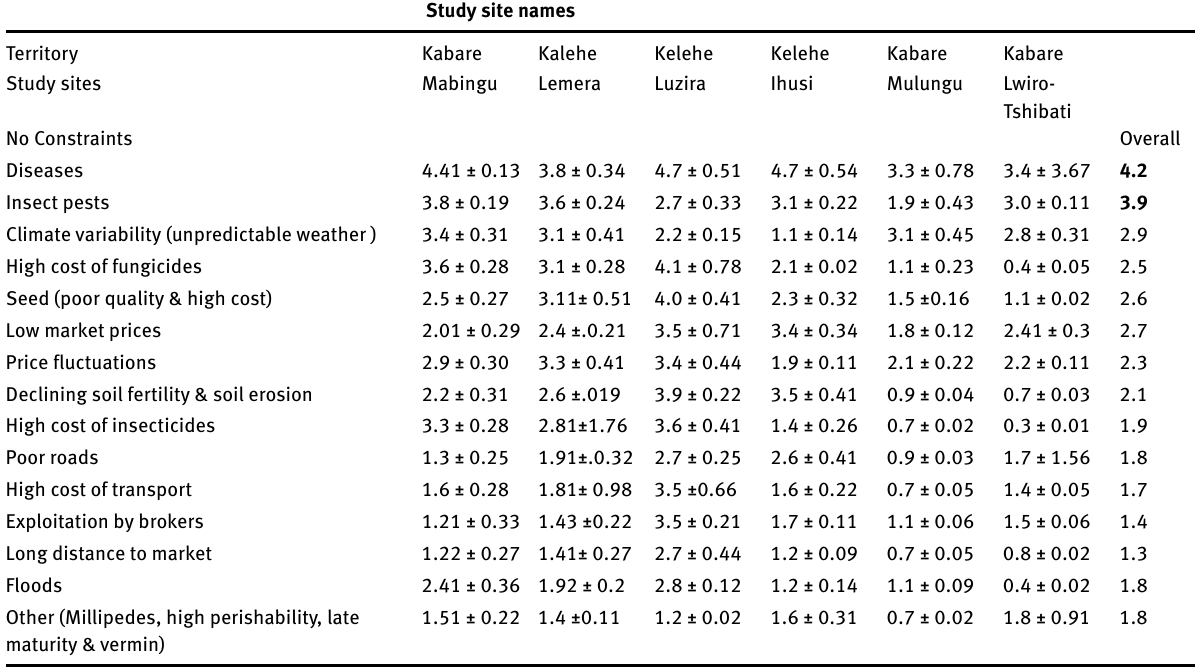
Table 3: Mean (x± SE) scores of severity of different constraints reported by potato farmers in the six study sites, South Kivu Province, eastern DRCongo (2016 survey, n= 300 farmers